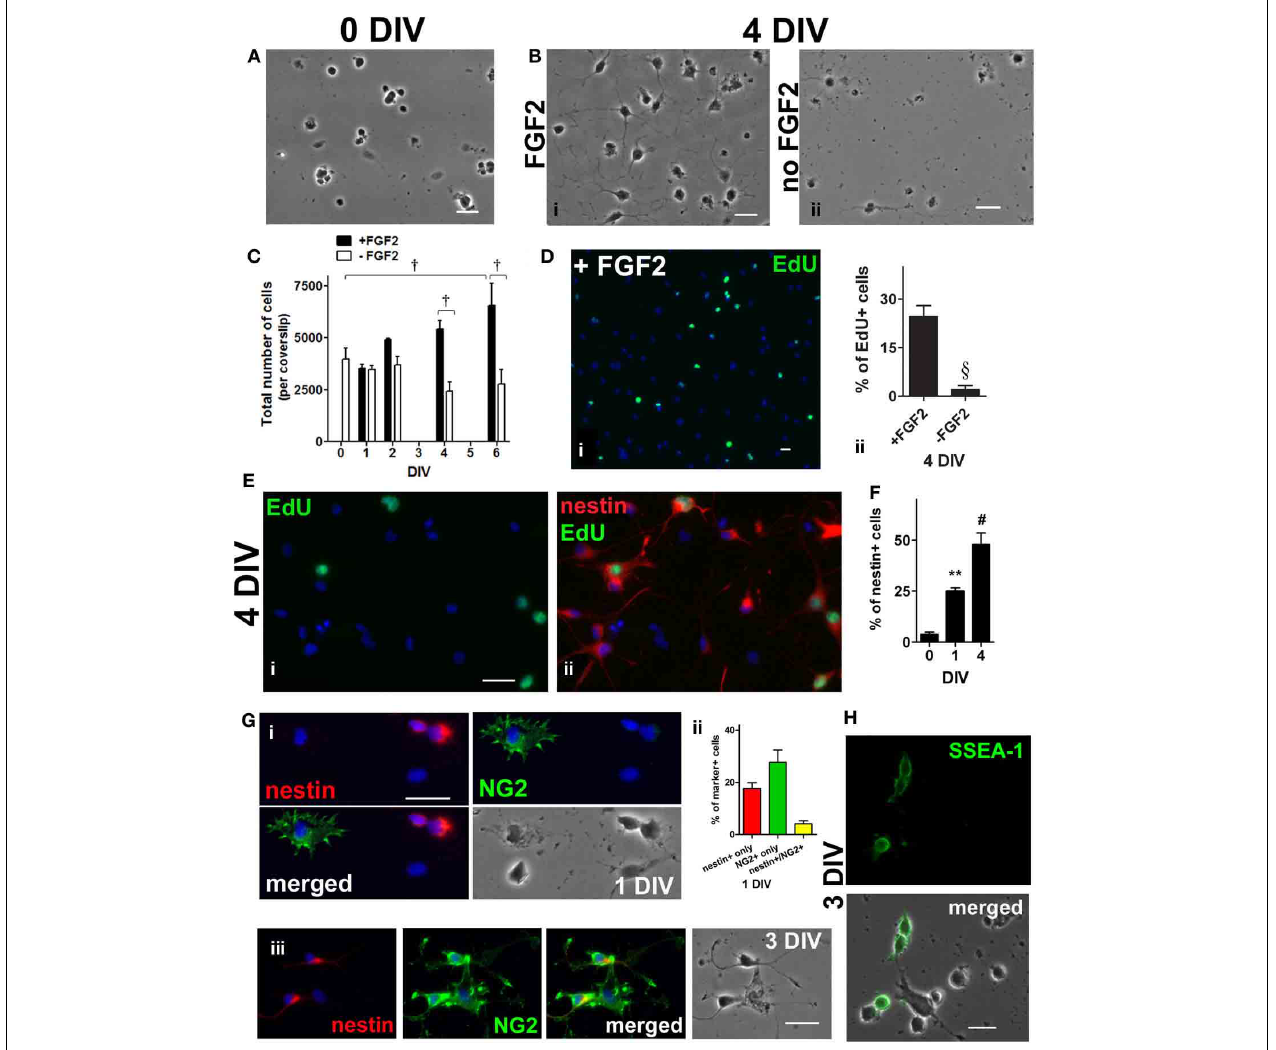
picture of the green and red channels showing EdU (green) and nestin (red) staining. Blue indicates Hoechst-stained nuclei. (F) Quantification of the percentage of nestin + cells showing that the population of NSPCs was enriched in culture medium containing FGF2 over time (20 random fields with a 40 × objective per coverslip were analyzed, n = 4 coverslips; ∗∗ P < 0 . 01, # P ≤ 0 . 0001, One-Way ANOVA Dunnett’s multiple comparison post-test). (G) Co-labeling of NG2 chondronitin sulfate proteoglycan (green) and nestin (red) at 1DIV (i) and 3DIV (iii). At 1DIV, most of the NG2 + cells had distinct morphology from nestin + cells; while cells coexpressing both markers were observed at 1 and 3DIV. Blue indicates Hoechst-stained nuclei. (ii) Quantification of the percentage of nestin + , NG2 + , and nestin + /NG2 + cells at 1DIV (20 random fields with a 40 × objective per coverslip were analyzed, n = 4 coverslips). (H) At 3DIV, stage-specific embryonic antigen 1 (SSEA-1) (green), a cell surface carbohydrate epitope found on uncommitted NSPCs, appeared to localize to the plasma membrane of cells with undifferentiated morphology. All scale bars: 20 μ m.